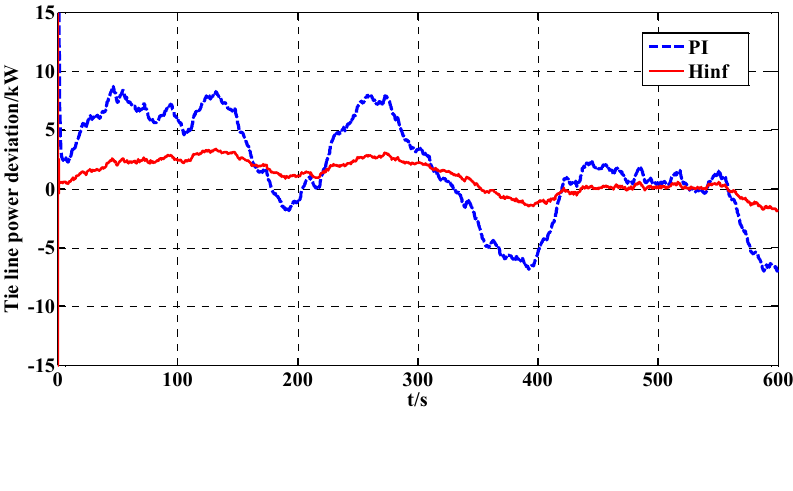
Figure 12. Tie-line power curves for case D under PI and proposed control